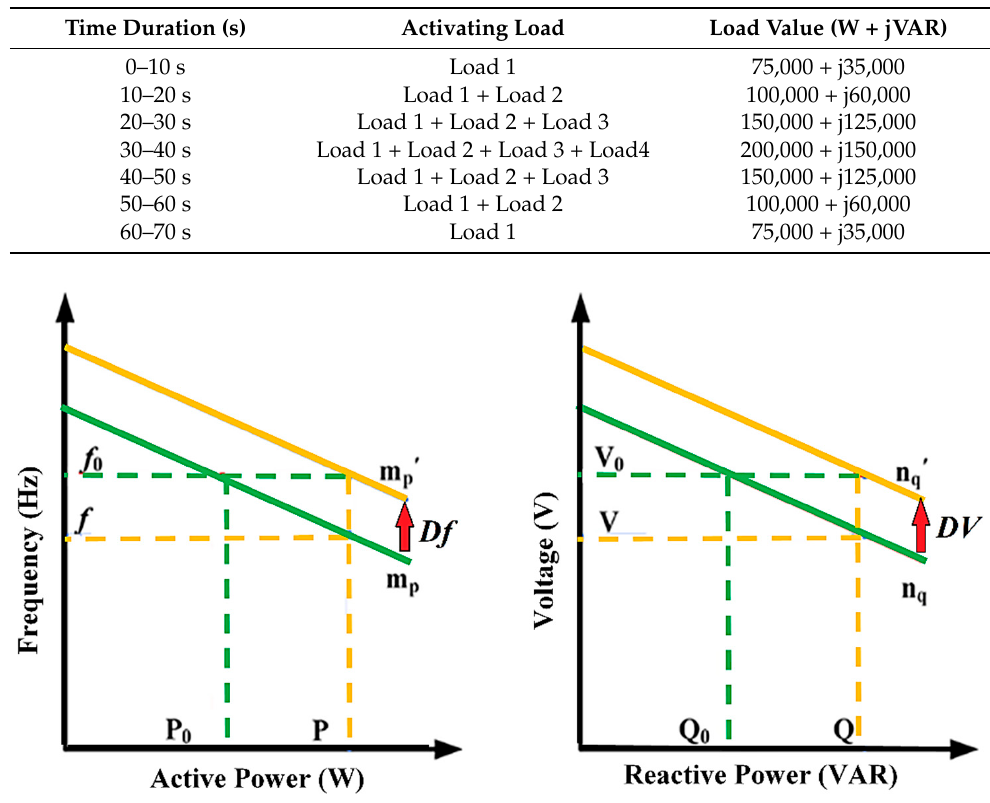
Table 3. Time-value-based active and reactive load power.